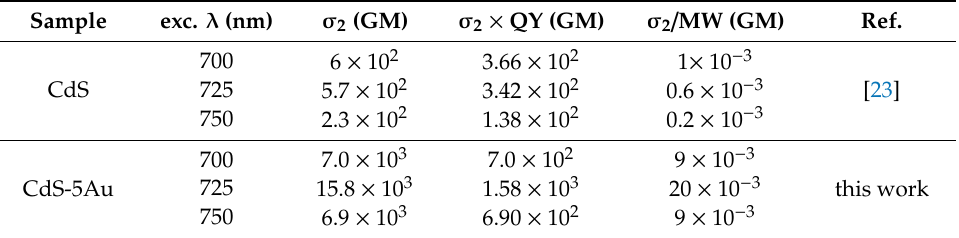
Table 1. Two-photon absorption cross sections σ 2 and two-photon brightness σ 2 × QY of as-prepared CdS-Au NPs in comparison with CdS NPs characterized in a previous work [23]. Exc. λ —excitation wavelength. QY, quantum